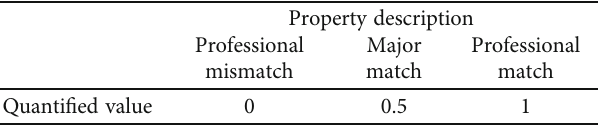
Table 2: Quanti fi cation of personnel professional match